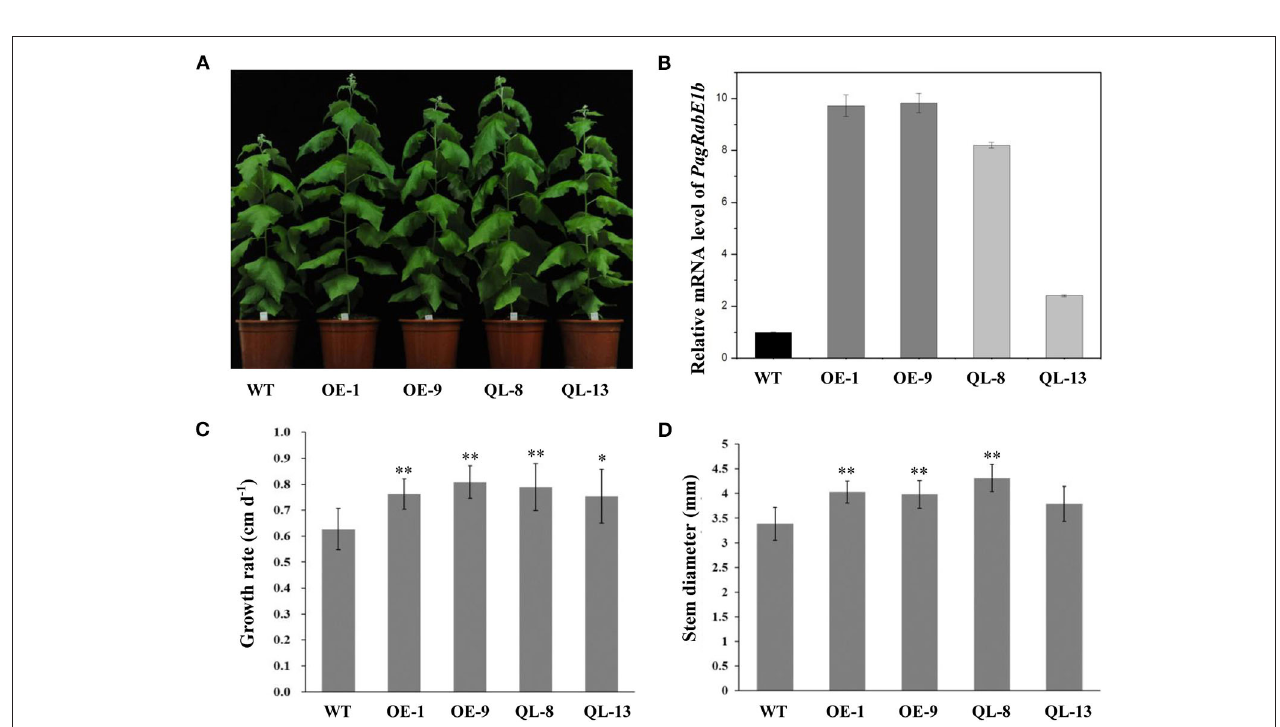
FIGURE 2 | Growth phenotypes of PagRabE1b transgenic poplars compared with wild type (WT). (A) A photograph of WT and PagRabE1b overexpression lines. Bar = 10cm; (B) qRT-PCR analyses of the transcript levels of PagRabE1b in WT, OE-1, OE-9, QL-8, and QL-13 lines. (C,D) The growth rate and basal diameter of 3-month-old WT, OE-1, OE-9, QL-8, and QL-13 lines. The growth rate and diameter: means ± SD of six clonally propagated plants. Student’s t -test; * P < 0.05; ** P <